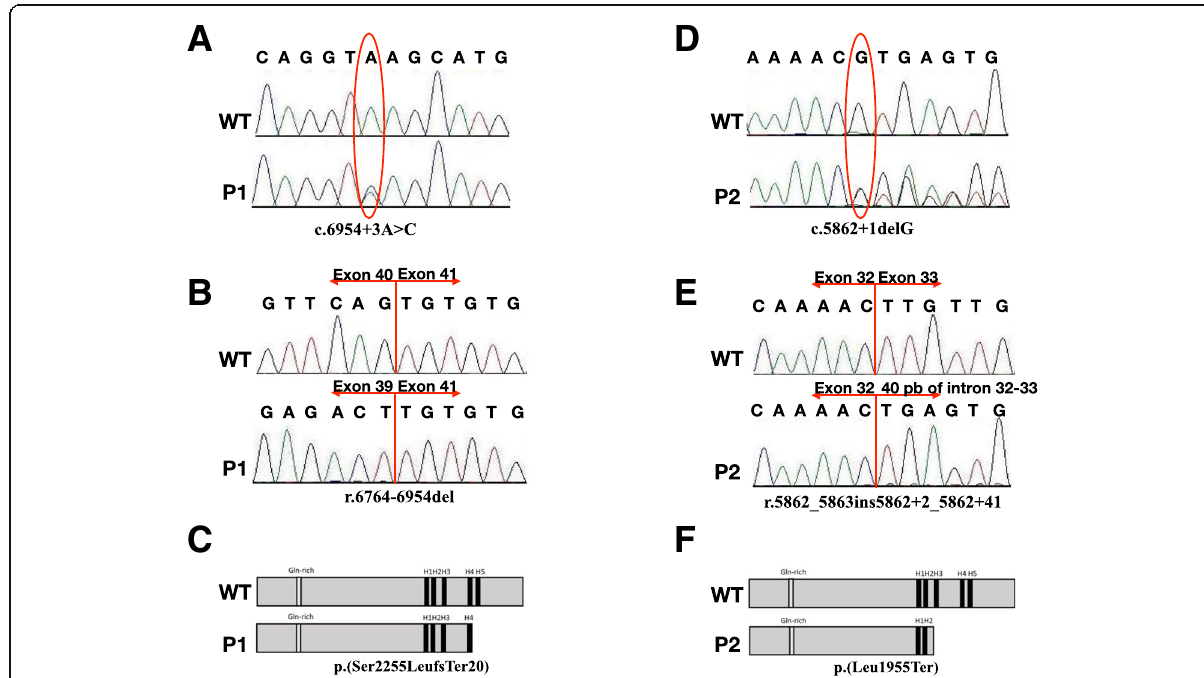
Fig. 1 Variant analysis of both individuals. a-c Analysis of Individual 1 variant - c.6954 + 3A > C. a Sequence analysis of exon 40 and intron 40 of the NIPBL gene. The wild-type control (top panel) and Individual 1 (bottom panel). The mutation is marked with a circle. b Sequence analysis of cDNA NIPBL gene. The wild-type control (top panel) and the bottom panel exhibit an in-frame deletion of exon 40 of NIPBL gene in Individual 1. c NIPBL protein alignment of the wild-type control (top panel) and the bottom panel of Individual 1 exhibit protein truncation and loss of H5 domain. d-f Analysis of Individual 2 variant - c.5862 + 1delG. d Sequence analysis of exon 32 and intron 32 of the NIPBL gene. The wild-type control (top panel) and Individual 2 (bottom panel). The mutation is marked with a circle. e Sequence analysis of cDNA NIPBL gene. The wild-type control (top panel) and the bottom panel exhibit an in-frame insertion of 40 nucleotides of intron 32 of NIPBL gene in Individual 2. f NIPBL protein alignment of the wild-type control (top panel) and he bottom panel of Individual 2 exhibit protein truncation and loss of H3, H4, and H5